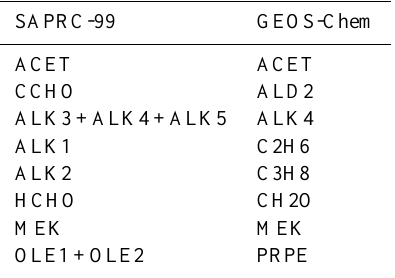
Table 3. Mapping table from SAPRC-99 species to MOZART-4 species.